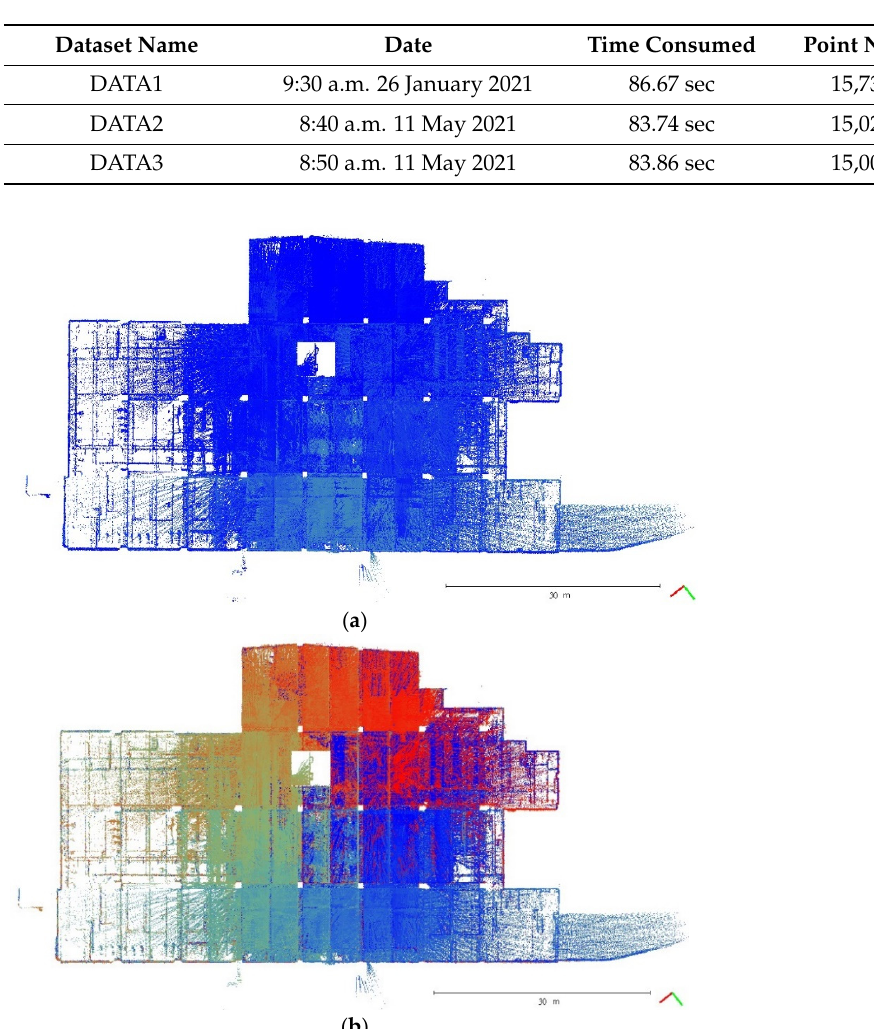
Figure 5. The top view of calibration dataset DATA1. ( a ) Point cloud colored by SLAM condition; ( b ) Point cloud colored by scanning time.